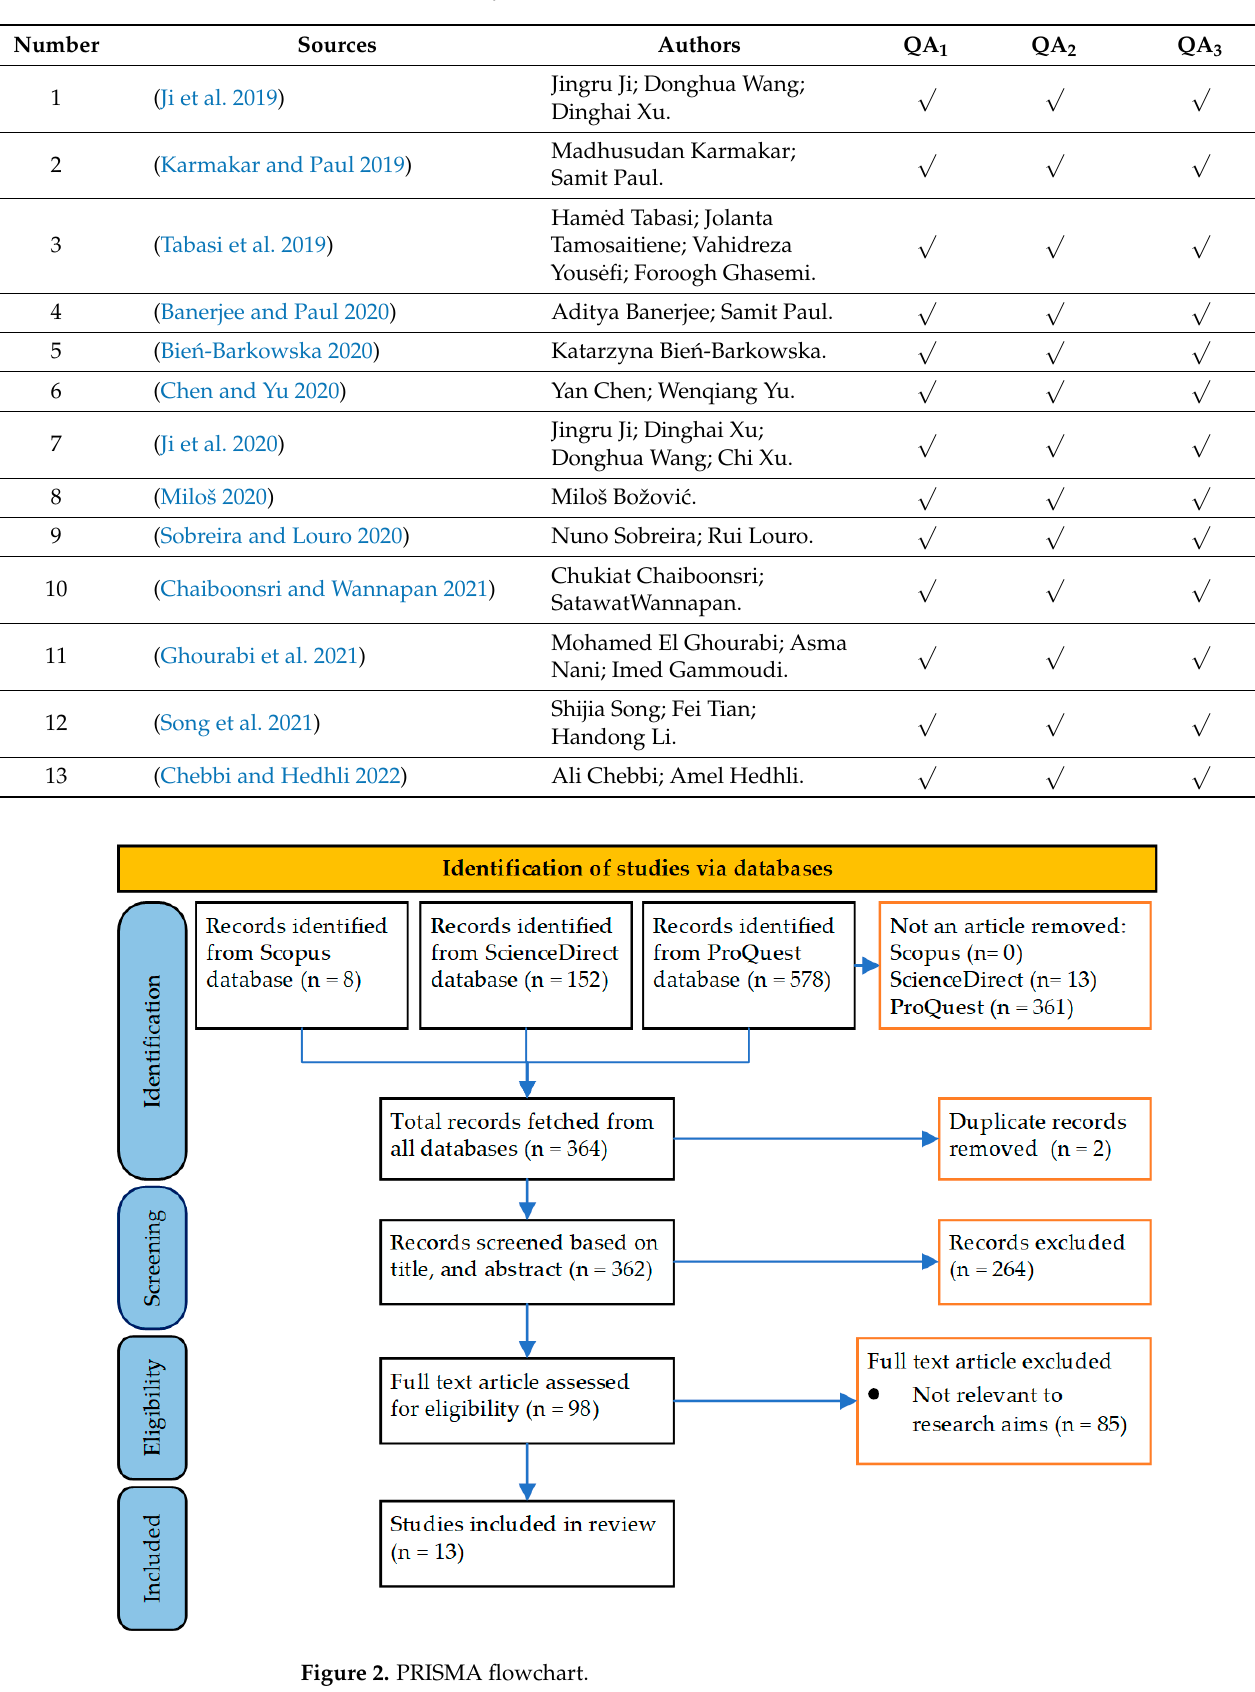
Table 5. Selection by QA.